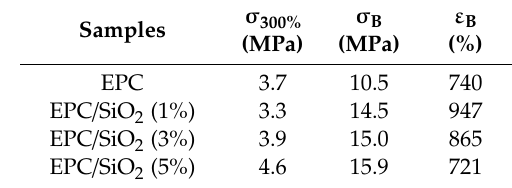
Table 1. Mechanical properties of EPC and its nanocomposites reinforced with SiO 2 nanoparticles.